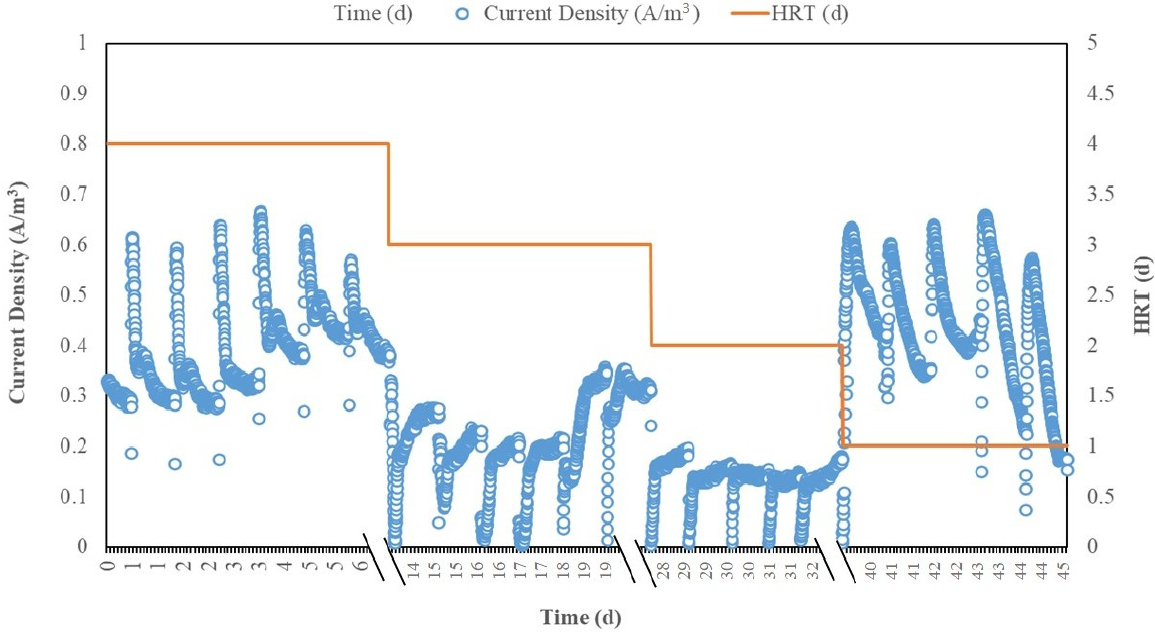
Figure 1. Volumetric current densities from microbial electrochemical cell (MEC) under different hydraulic residence times (HRTs).